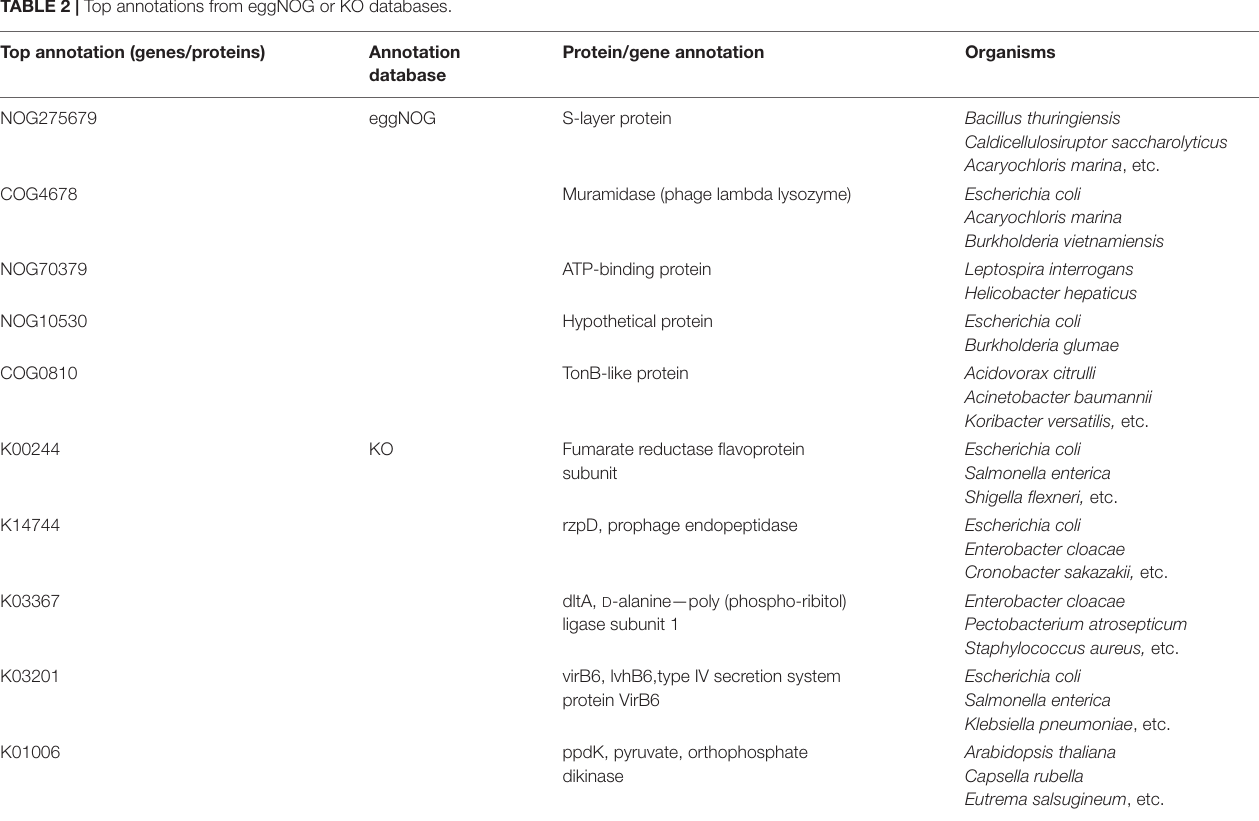
TABLE 2 | Top annotations from eggNOG or KO